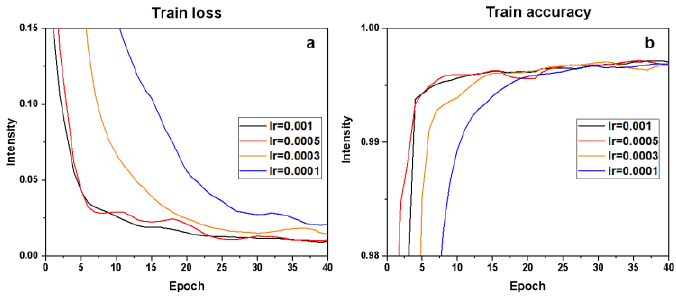
Fig. 1. The training results based on different learning rates. (a) The training loss curve based on different basic learning rates. (b) The training accuracy curve based on different basic learning rates.